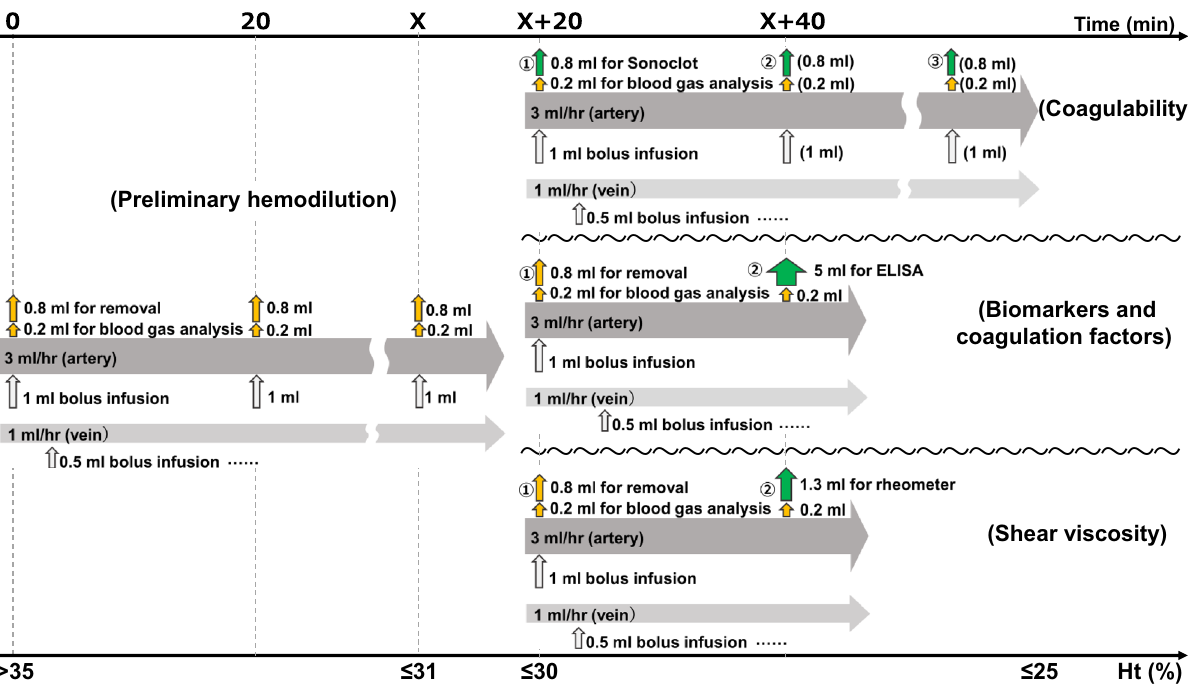
Figure 1. Hemodilution protocol. All hemodilution procedures were performed consecutively, first by the preliminary hemodilution method, followed by secondary hemodilution in different ways depending on what was measured. Ht hematocrit, ELISA enzyme-linked immunosorbent assay. X time at which the Ht level reached ≤ 31%. Yellow arrow, external; green arrow, external (sampling); white arrow,